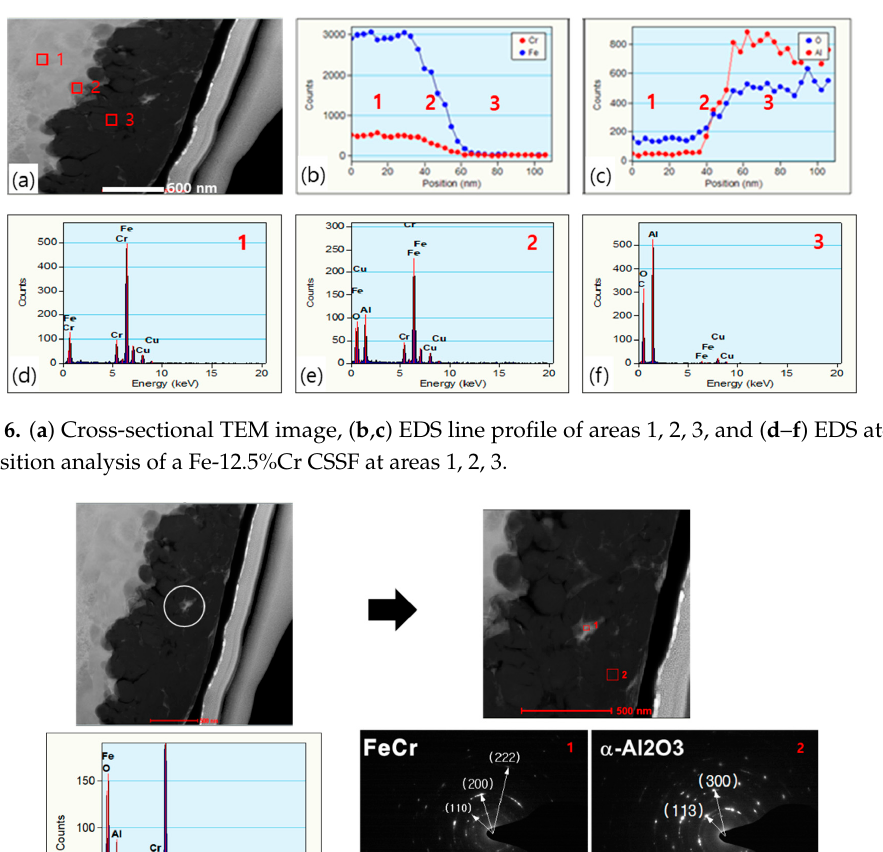
Figure 5. Shapes of ( a ) Fe-12.5%Cr CSSFs and ( b ) Fe-6.5%Si CSSFs milled for 30 min (found via a planar SEM) and the thickness of shell layers (found by a cross-sectional SEM).